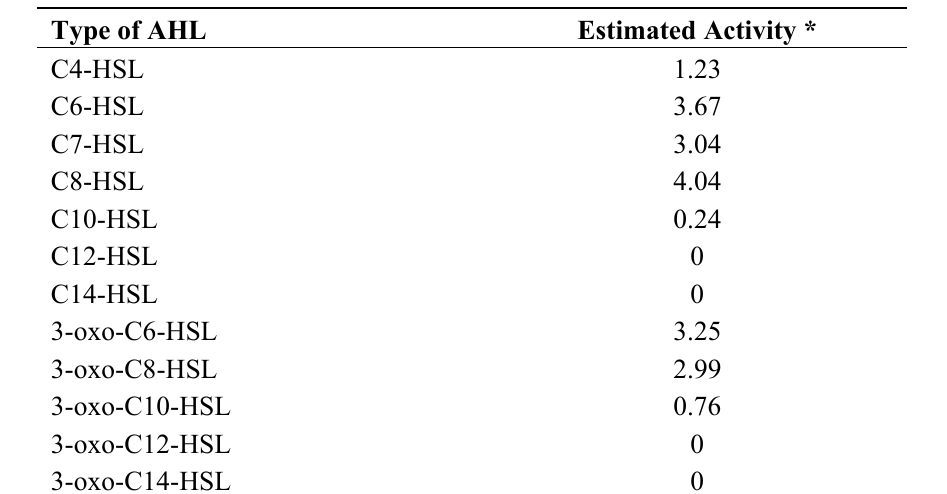
Table 1. Degradation of various AHLs by T. loubieri strain